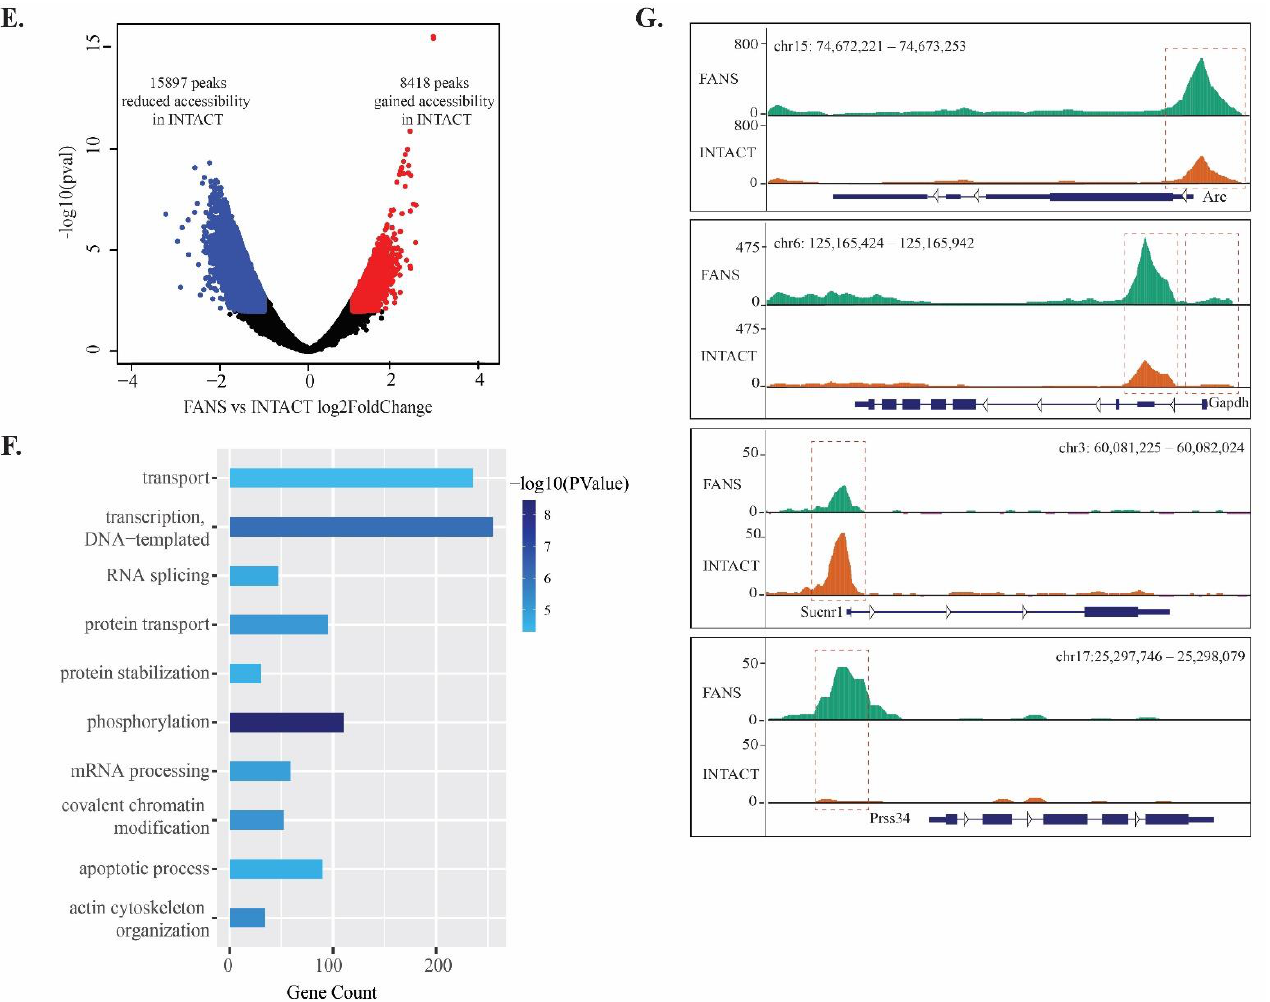
Figure 5. Chromatin accessibility comparison between FANS- and INTACT-nuclei: ( A ) average peak number in FANS and INTACT; ( B ) mapped reads coverage at transcriptional start site (TSS) in FANS and INTACT; ( C , D ) peak distribution across distinct genomic regions of FANS ( C ) and INTACT ( D ); ( E ) volcano-plot of differentially accessible regions (DARs) between INTACT and FANS; ( F ) GO term enrichment analysis for INTACT loss-accessibility genes compared to FANS; ( G ) genome browser tracks of selected genes Arc (IEGs), Gapdh (positive control), Sucnr1 (Gained accessibility in INTACT), and Prss34 (Gained accessibility in FANS).